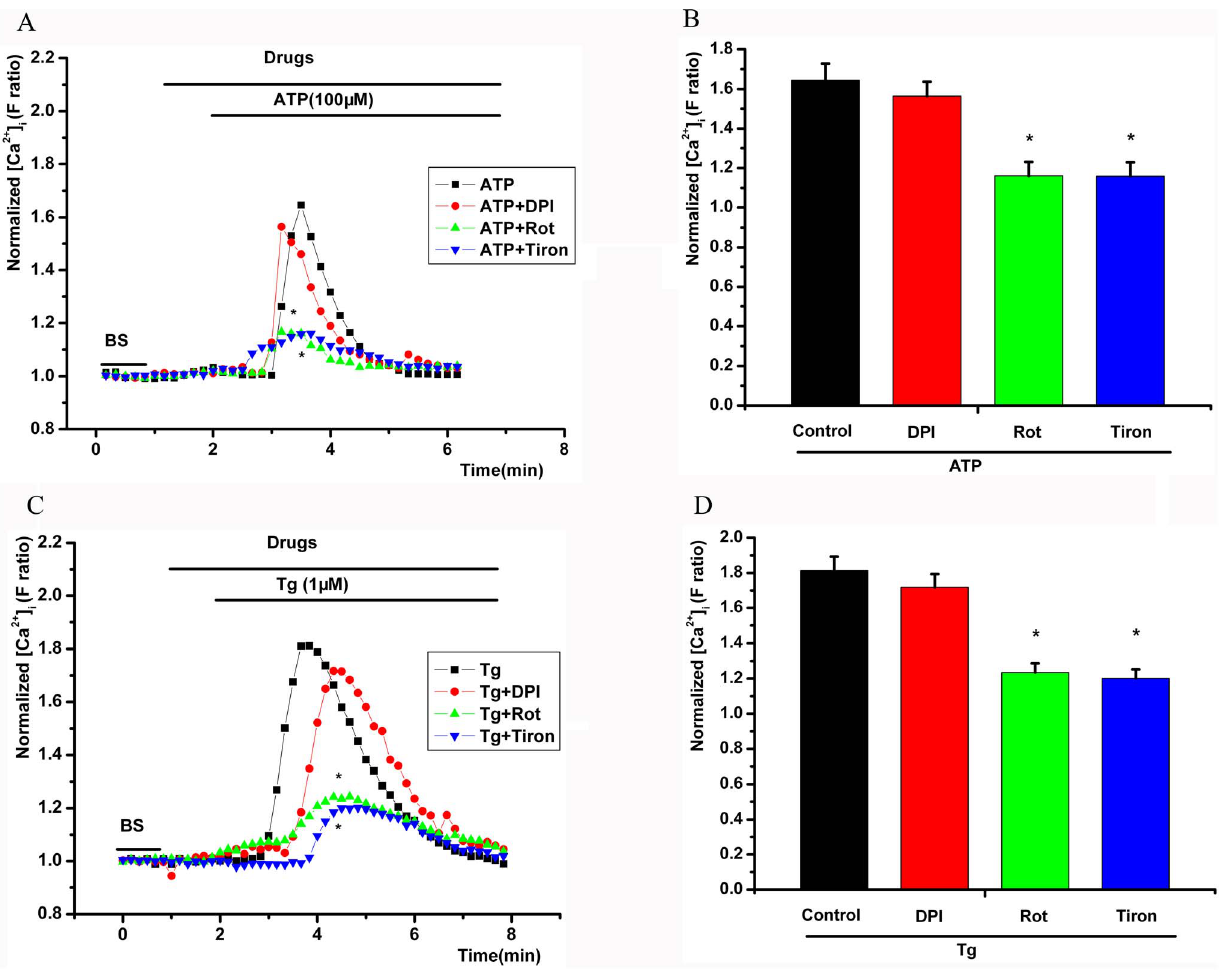
Figure 4. Effect of various intracellular ROS inhibitors on the [Ca 2 + ] i transient elevation induced by extracellular ATP. A, C, time series of the mean F ratio during the application of different agents. B, D, the maximal [Ca 2 + ] i with different agents. The NADPH oxidase inhibitor diphenyleneiodonium (DPI, 10 m M) did not decrease the ATP- or Tg-induced maximal [Ca 2 + ] i . However, the ROS scavenger tiron (1 mM) and mitochondrial inhibitor rotenone (Rot, 5 m M) inhibited the extracellular ATP- and Tg-induced maximal [Ca 2 + ] i . * P , 0.05, compared with the control. ( P , 0.05, Figure 3 A, B). Pinacidil (100 m M) and other unselective potassium channel blockers (TEA and 4-AP) did not change the maximal [Ca 2 + ] i (Figure 3 A, B). The mitochondrial K ATP blocker 5-HD (100 m M) also decreased the maximal [Ca 2 + ] i ( P , 0.05, Figure 3 A, B). When simultaneously pretreated with glibencla-